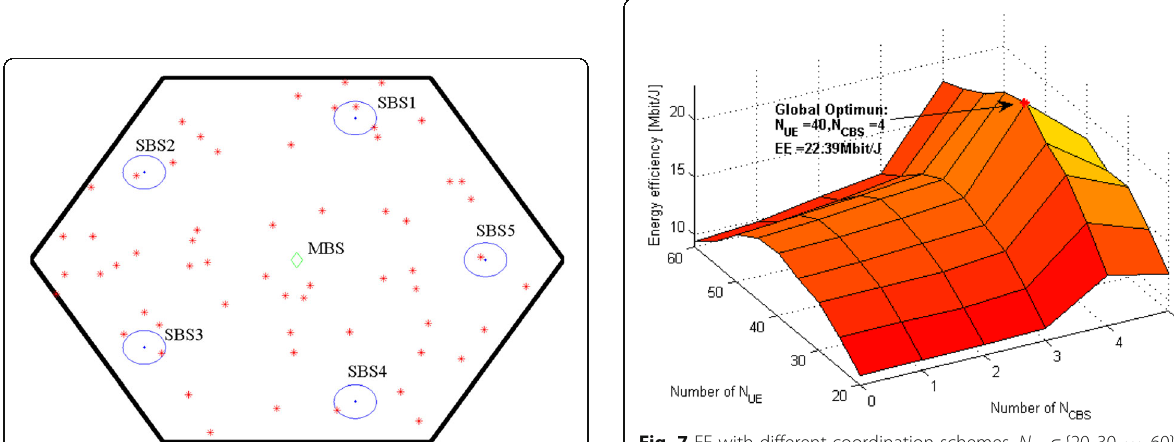
Fig. 7 EE with different coordination schemes, N UE ∈ {20, 30, ⋯ , 60}, R = 2bit/s/Hz, and N BS =